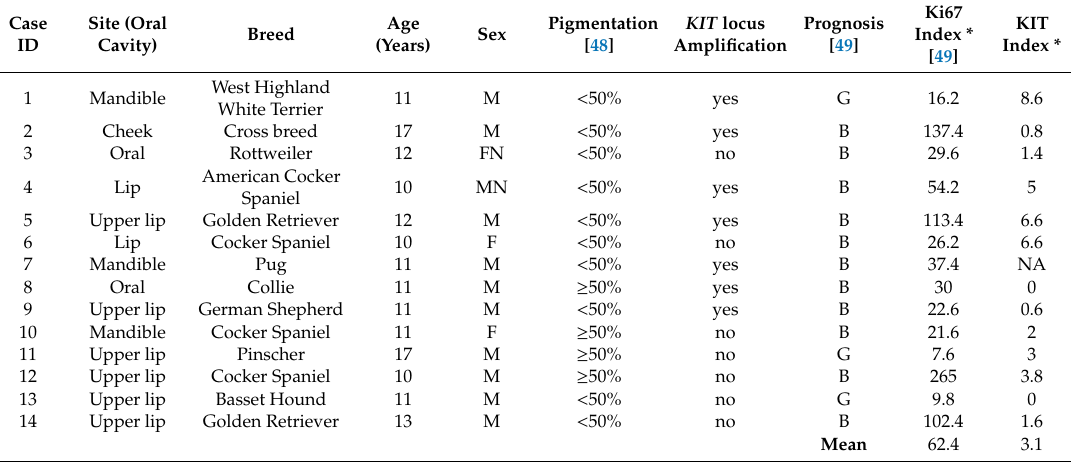
Table 1. Selected samples included in the study, together with available clinical and histological data, immunohistochemistry (IHC) indexes, and amplification status. B: bad prognosis; F: female; FN: neutered female; G: good prognosis; M: male; MN: neutered male; NA: not available; * mean number of positive cells in 5 high-power fields (hpf).